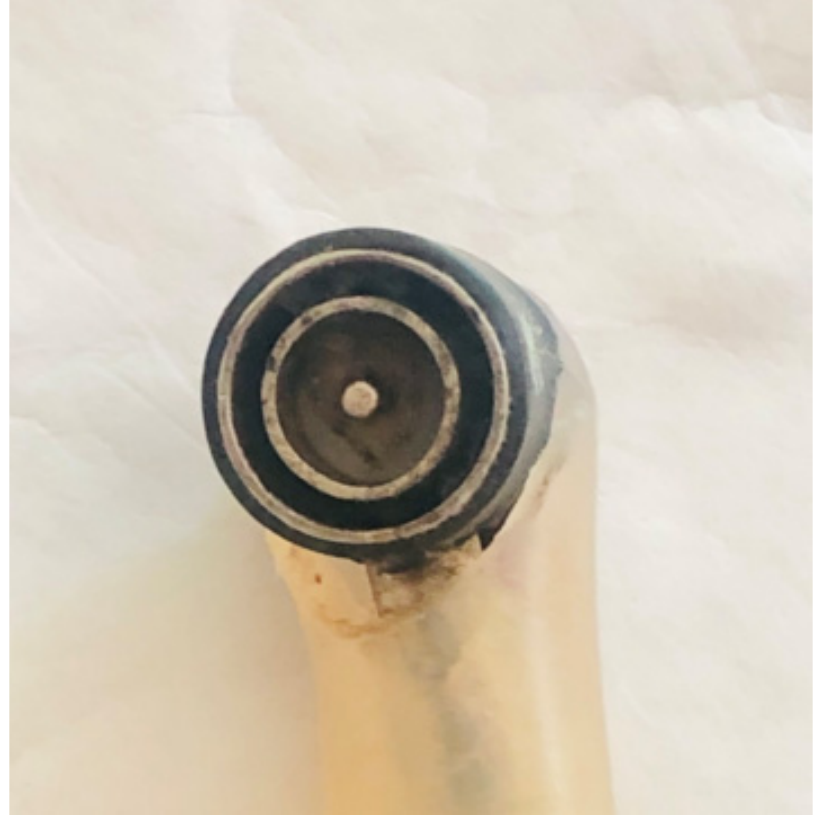
Figure 1. Intraoral probe consisting of 3 concentric aluminium alloy electrodes. EI was measured in 14 points (bilaterally in 7 anatomical regions of the oral cavity, i.e., in the upper lip mucosa, lower lip mucosa, hard palate, buccal mucosa, tongue dorsum, ventral tongue, and sublingual mucosa). The measurement was performed by placing the probe against the selected point on the mucosa. When the sub pressure of 250 mB was reached, which was confirmed by the vacuum gauge (Yuyao Yadong Plastic, Huangzhou, China), the device was turned on, and the EI for the respective point was registered through nine frequencies (1, 2, 5, 7, 10, 20, 70, and 100 kHz). The measurement was first performed with a probe sub pressure of 250 mBar, and after that, the whole procedure was performed with a sub pressure of 350 mBar. All measurements were performed by a single examiner. Three sets of measurements were performed for each participant, and the average EI value was used for further calculations.